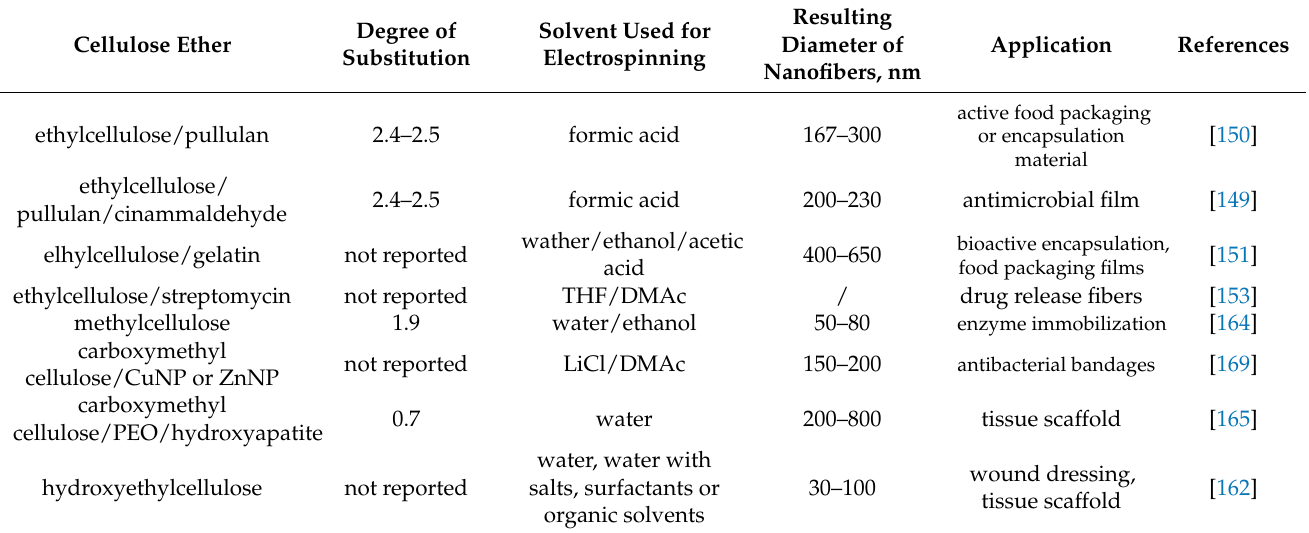
Table 6. Electrospinning of cellulosic ethers and areas of application of nanofibrous